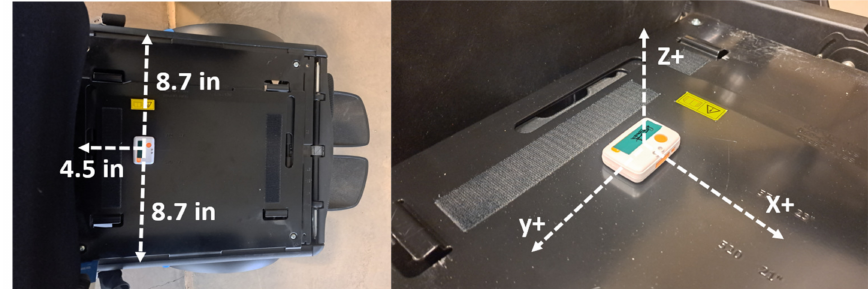
Figure 2. Location ( Left ) and orientation ( Right ) of the Shimmer 3 on the